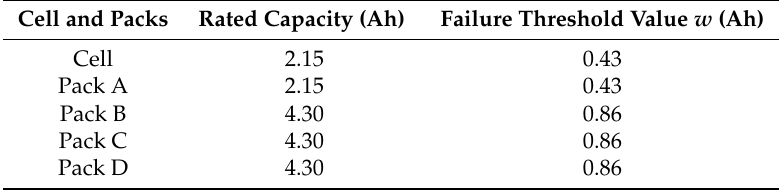
Table 1. The failure threshold for the cell and the four battery packs.